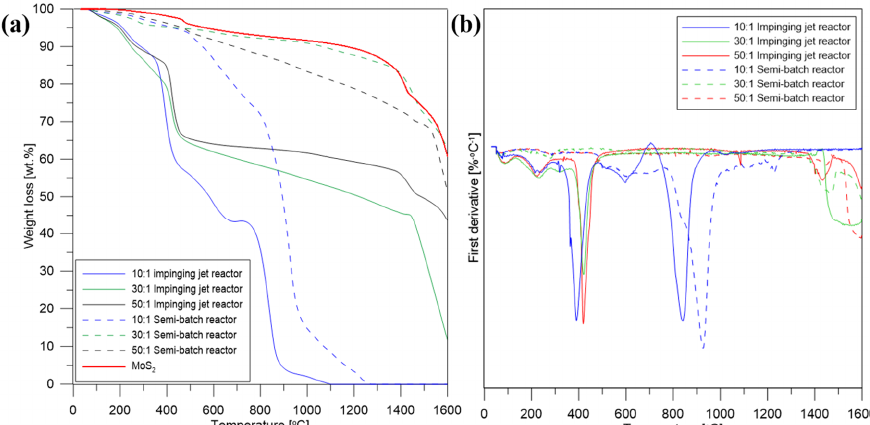
Figure 5. ( a ) Thermogravimetric analysis and ( b ) derivative thermogravimetric of the hybrid Figure 5. ( a )Thermogravimetricanalysisand( b )derivativethermogravimetricofthehybridnanostructures nanostructures and MoS 2. and MoS 2.